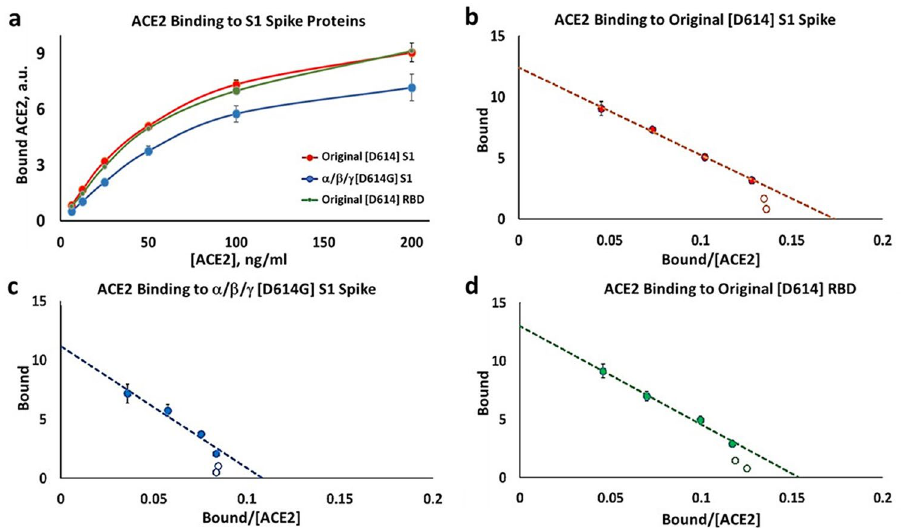
Figure 1. Binding of ACE2 to the SARS-CoV-2 Spike variants. ( a ) Substrate-Binding plots for original [D614] S1 spike (red), α/β/γ [D614G] S1 spike (blue), and original [D614] RBD (green) proteins. ( b – d ) Eadie–Hoffstee plots of data in Part (a) for original [D614] S1 spike ( b ), α/β/γ [D614G] S1 spike ( c ), and original [D614] RBD from the S1 spike ( d ). Note concave-down structure at low binding levels. Each point is the average ± SE for N = 5–6 independent experiments.